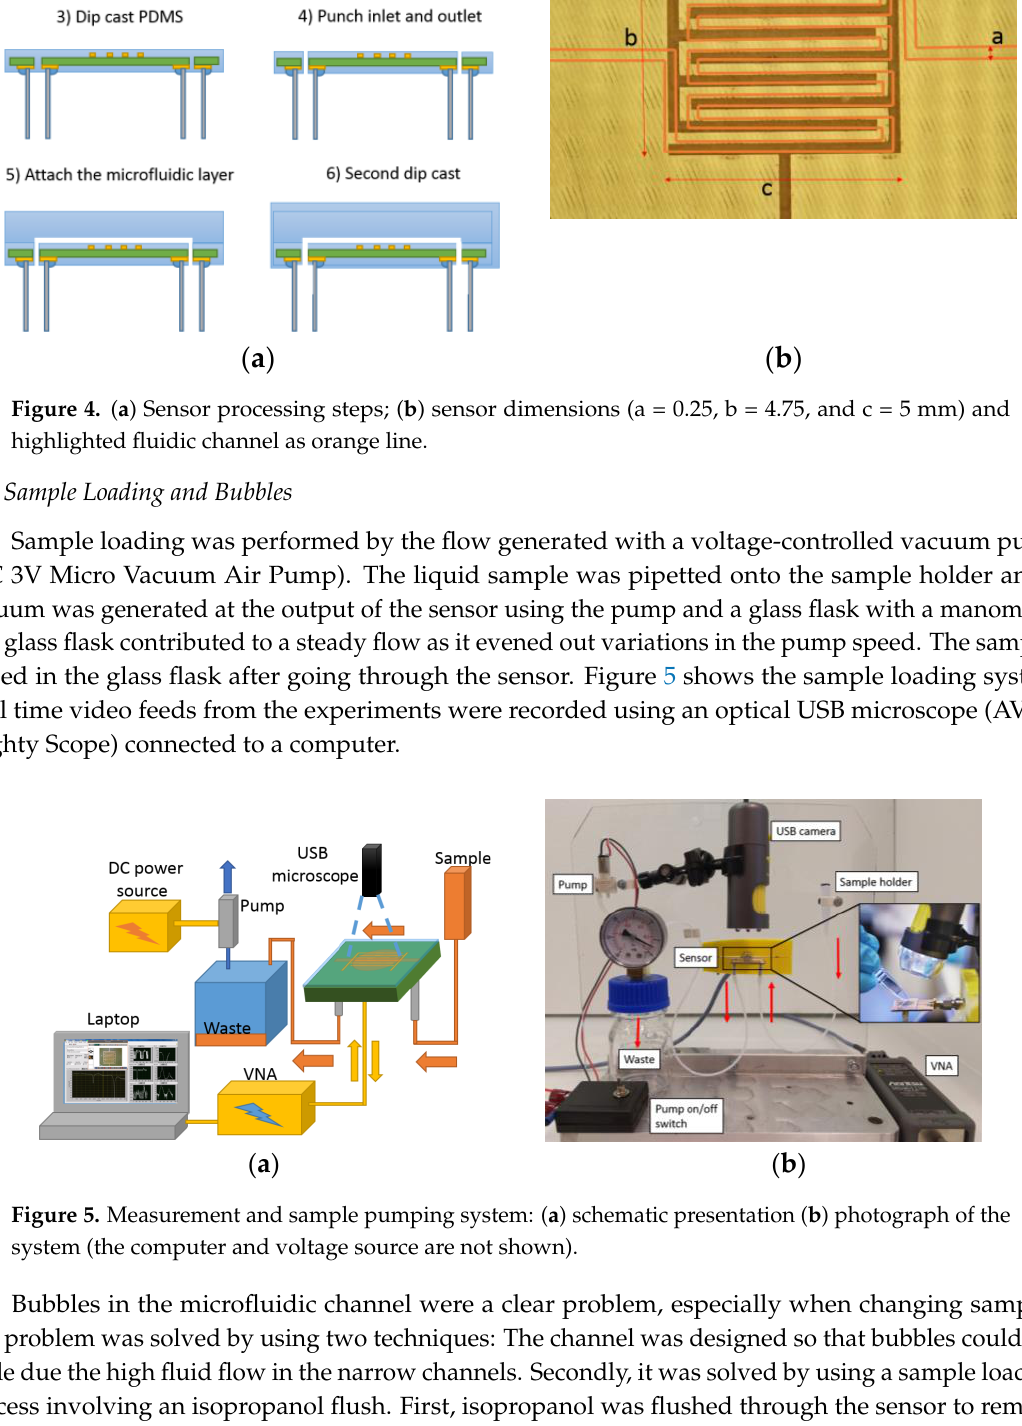
Figure 4. ( a ) Sensor processing steps; ( b ) sensor dimensions (a = 0.25, b = 4.75, and c = 5 mm) and highlighted fluidic channel as orange line.